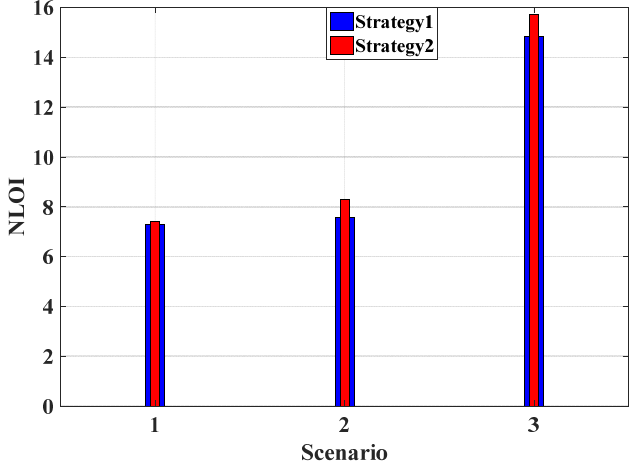
Figure 9. The comparative result of the NLOI indices.